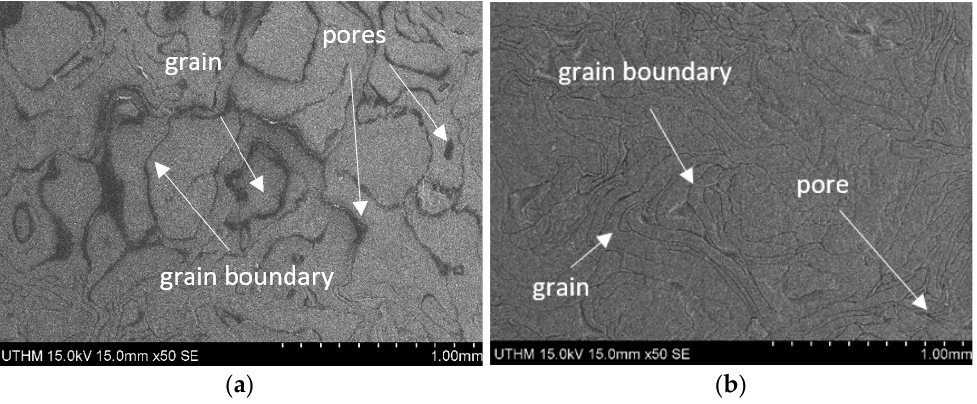
Figure 6. Minimum and maximum parameters of the microstructure at 50 × magnification for samples